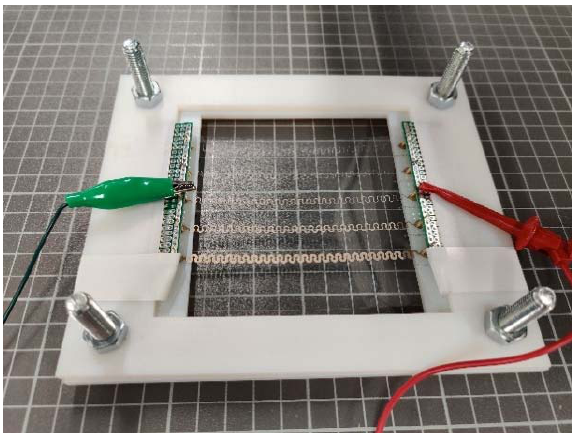
Figure 5. Test sample installed on test jig.